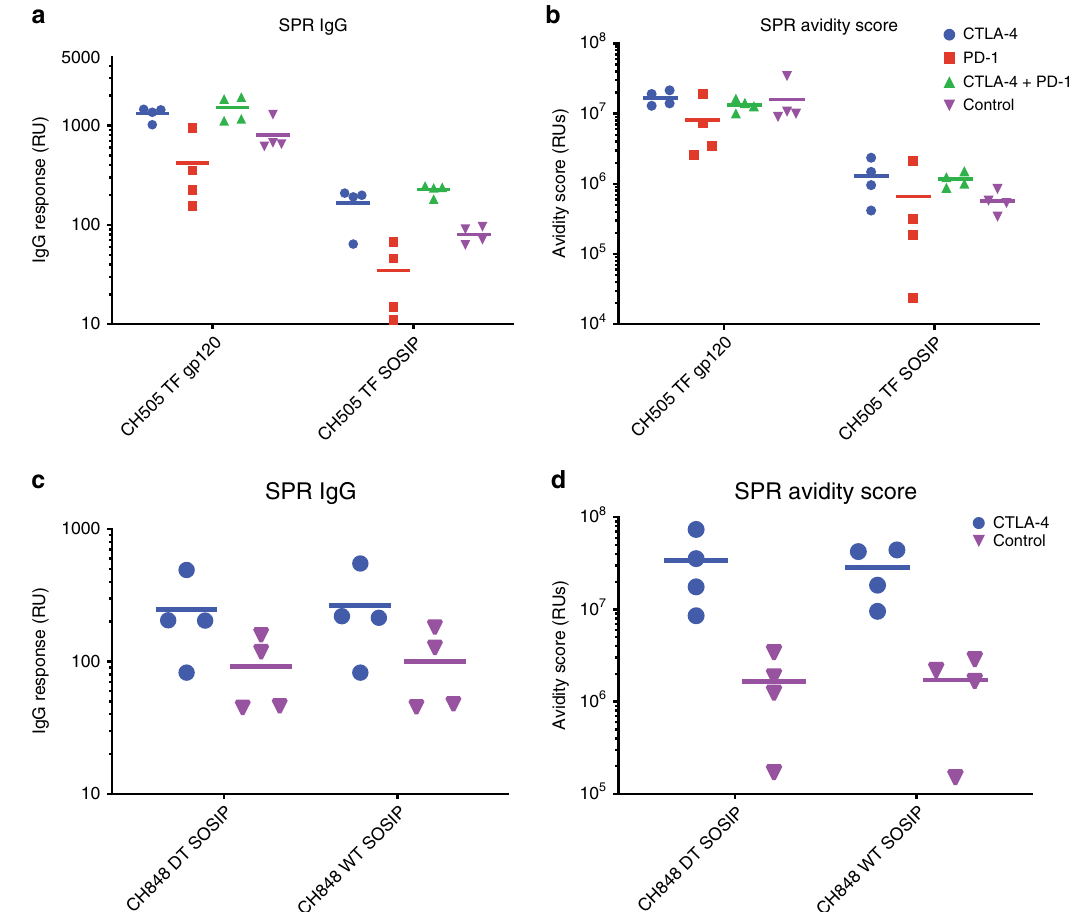
Fig. 2 Antibody IgG af fi nity and avidity measured by SPR after HIV-1 Env vaccination. a , b Puri fi ed plasma IgG ( a ) binding and ( b ) avidity as measured by surface plasmon resonance (SPR) to CH505 TF gp120 and CH505 TF SOSIP trimer proteins. Each dot represents a single animal and are colored based on the antibody treatment group (CTLA-4, blue; PD-1, red; CTLA-4 + PD-1, green; Control CH65, purple). c , d Puri fi ed plasma IgG ( c ) binding and ( d ) avidity as measured by surface plasmon resonance (SPR) to CH848 DT and CH848 WT SOSIP trimer proteins. Each dot represents a single animal and are colored based on the antibody treatment group (CTLA-4, blue; Control CH65, purple). Source data are provided as a Source Data fi